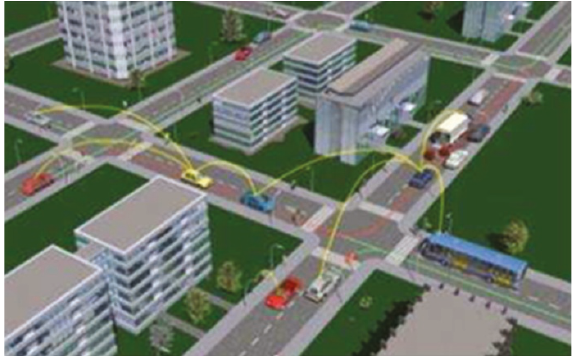
Figure 1: Vehicular Ad hoc Network.